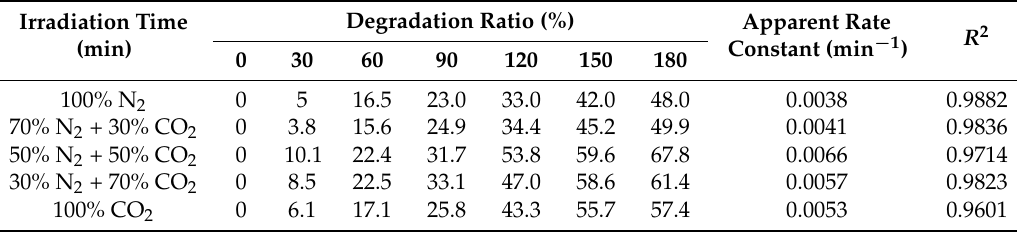
Table 2. Degradation ratio, apparent rate constant, and correlation coefficient ( R 2 ) of chlorobenzene with Cu 2+ /K 2 La 2 Ti 3 O 10 at 500 ◦ C under different CO 2 concentrations. Degradation Ratio (%) Apparent Rate Irradiation Time Constant (min − 1 (min)